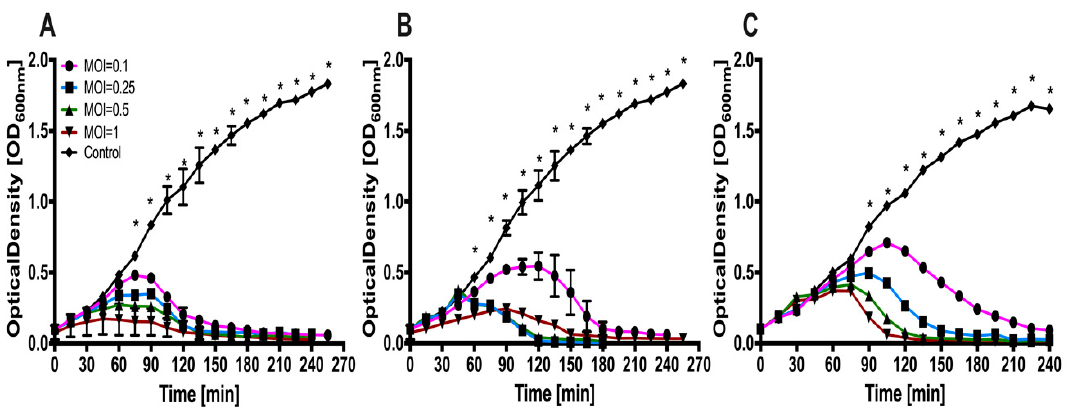
Figure 3. Bacteriolytic activity of phages vB_SauM-A, vB_SauM-C, vB_SauM-D at different multiplicities of infection (MOIs) (that are 0, 0.1, 0.25, 0.5 and 1) against representative MDR S. aureus strains in liquid culture. Each curve represents the average results for three replicates, error bars represent standard deviation (SD) ( A ) Growth curves of S. aureus 203 infected with vB_SauM-A ( B ) Growth curves of S. aureus 343 infected with vB_SauM-C ( C ) Growth curves of S. aureus 343 infected with vB_SauM-D. Statistically significant di ff erence was highlighted by asterisk (*). Only those time points at which all measured optical density (OD) values were significantly di ff erent when compared to control, were